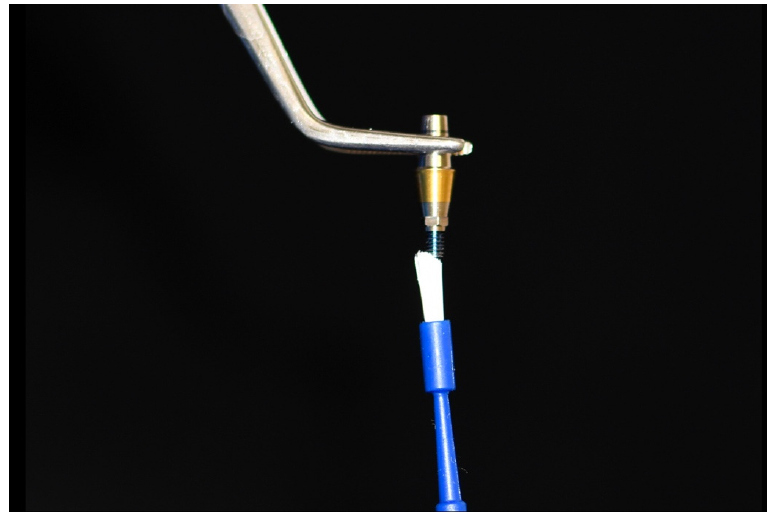
Figure 1. Application of Impladhesive bio-adhesive to the abutment screw threads.